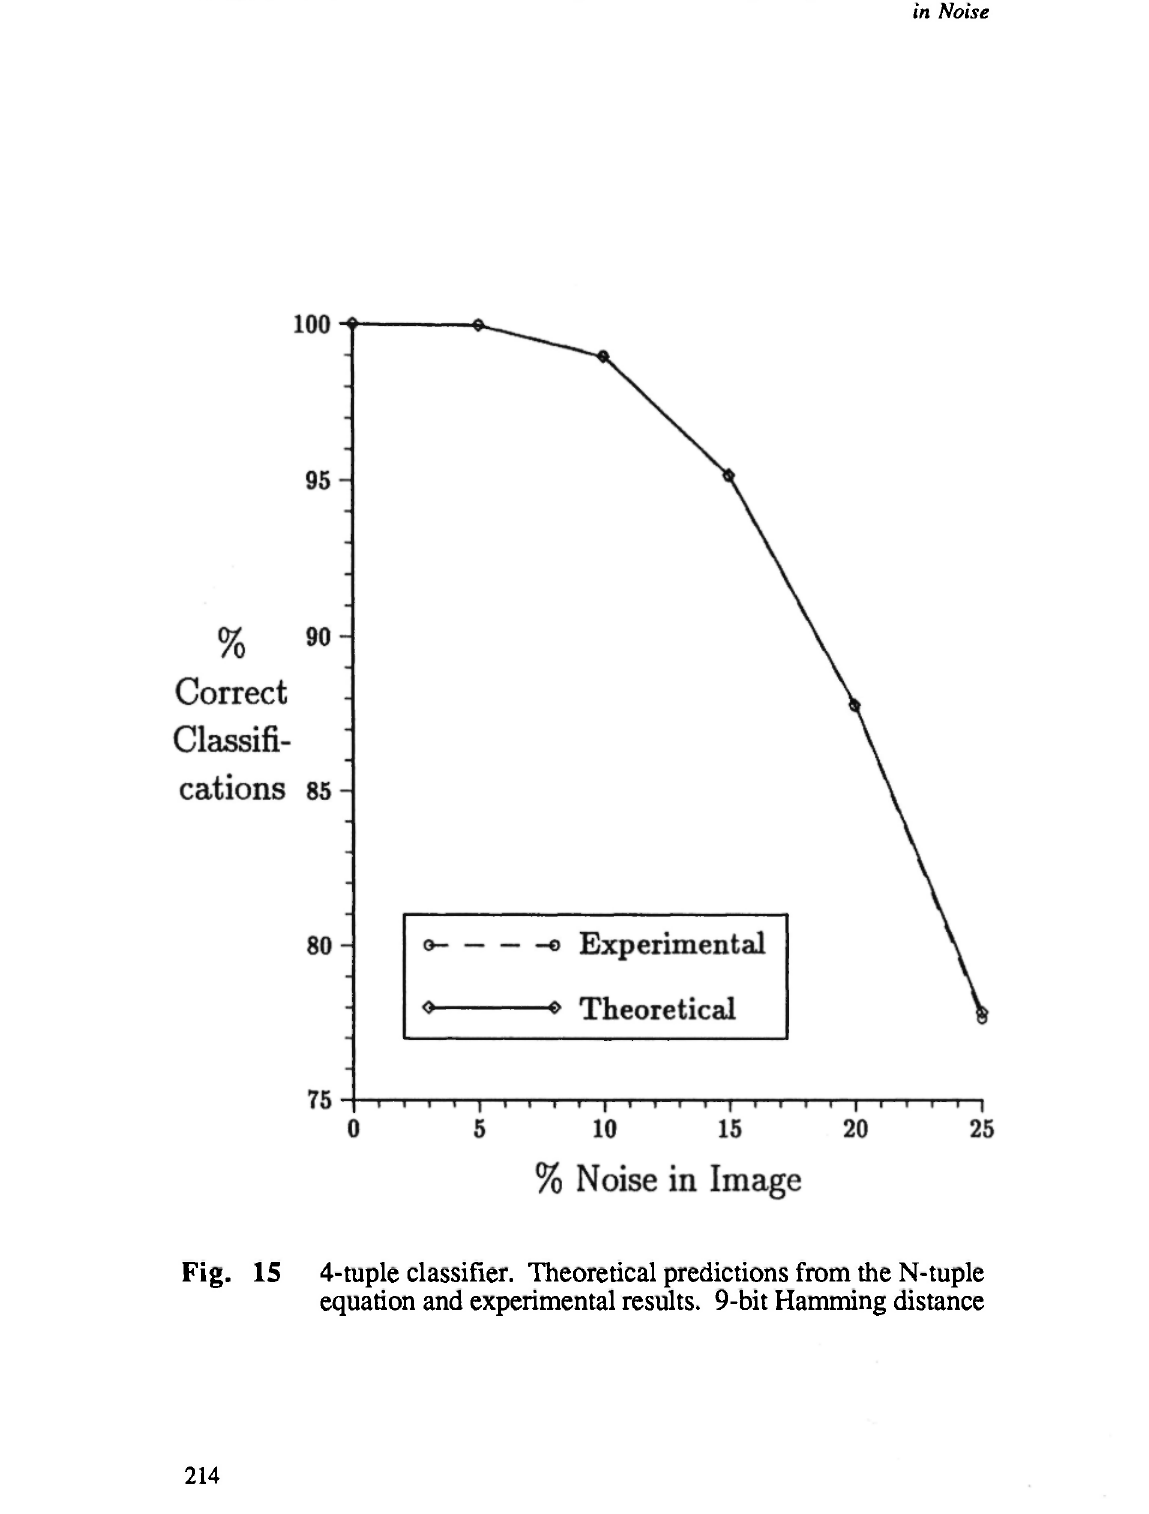
Fig. 15 4-tuple classifier. Theoretical predictions from the N-tuple equation and experimental results. 9-bit Hamming